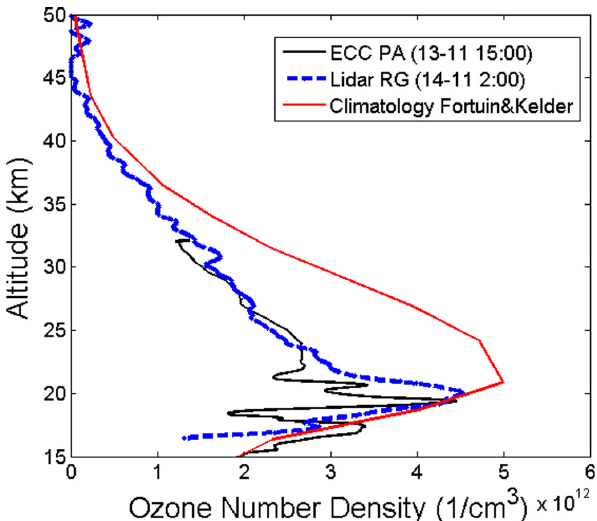
Fig. 5. Intercomparison of lidar ozone profile on 14 November 2009 (start time 02:00 UTC) measured at R´ıo Gallegos (blue dashed line) and ECC ozonesonde launched on 13 November (15:00UTC) in Punta Arenas, Chile (black line). Fortuin and Kelder climatological profile for 45 ◦ –55 ◦ latitude south band is also plotted as a reference (red